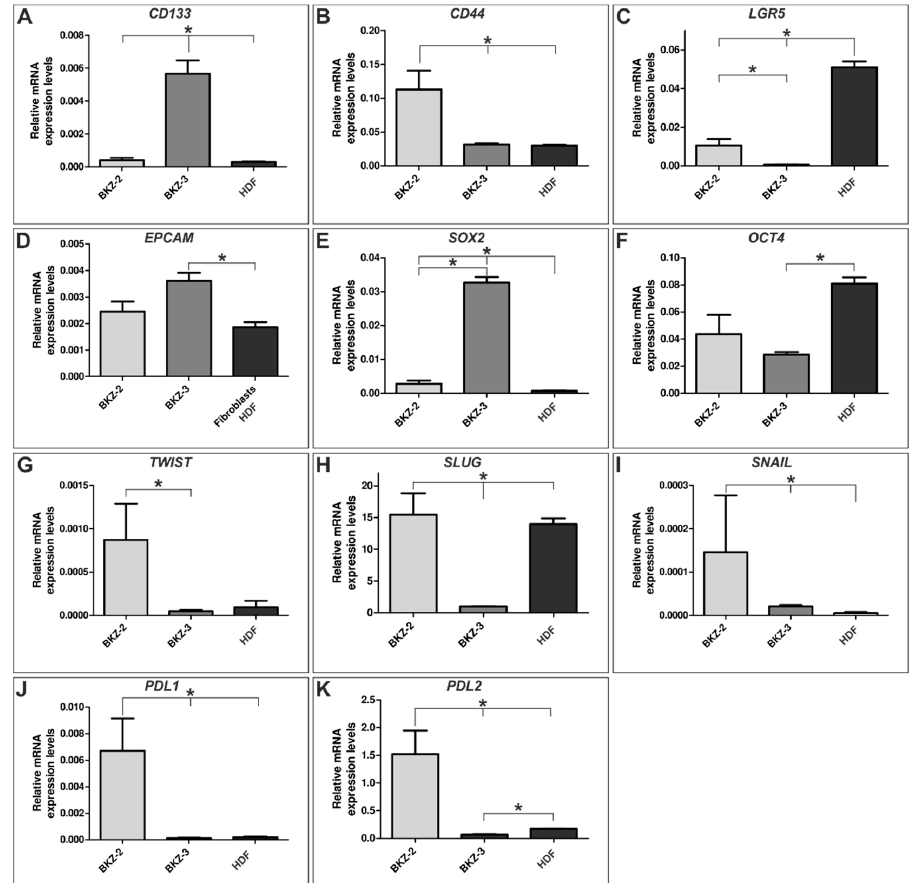
Figure 7. BKZ-2 and BKZ-3 show higher messenger ribonucleic acid (mRNA)-level of cancer stem cell (CSC)- and epithelial-mesenchymal-transition (EMT)-markers as well as immune checkpoint ligands in comparison to human dermal fibroblasts (HDF). Quantitative polymerase chain reaction revealed an expression of CSC-markers ( A ) prominin-1 ( CD133 ), ( B ) CD44 antigen ( CD44 ), ( C ) leucine rich repeat containing G protein-coupled receptor 5 (LGR5 ), ( D ) epithelial cell adhesion molecule ( EPCAM ), ( E ) SRY-box transcription factor 2 ( SOX2 ) and ( F ) octamer-binding transcription factor 4 ( OCT4 ) in both cell lines. Comparison of the two cell lines, demonstrated significant differences of the relative mRNA expression for CD133 , CD44 , LGR5 and SOX2 . Further analysis revealed an expression of the key transcription factors of the process of EMT ( G ) twist family bHLH transcription factor 1 ( TWIST ), ( H ) snail family transcriptional repressor 2 ( SLUG ) and ( I ) snail family transcriptional repressor 1 ( SNAIL ), with TWIST and SLUG being significantly different expressed in BKZ-2 and BKZ-3. Moreover, quantification displayed a significantly altered expression of the immune checkpoint ligands ( J ) programmed death ligand 1 ( PDL1 ) and ( K ) programmed death ligand 2 ( PDL2 ) in the two cell lines. Non-parametric Mann-Whitney-test ( p ≤ 0.05). n = 3, * p ≤ 0.05. Mean ± SEM (standard error of the mean).